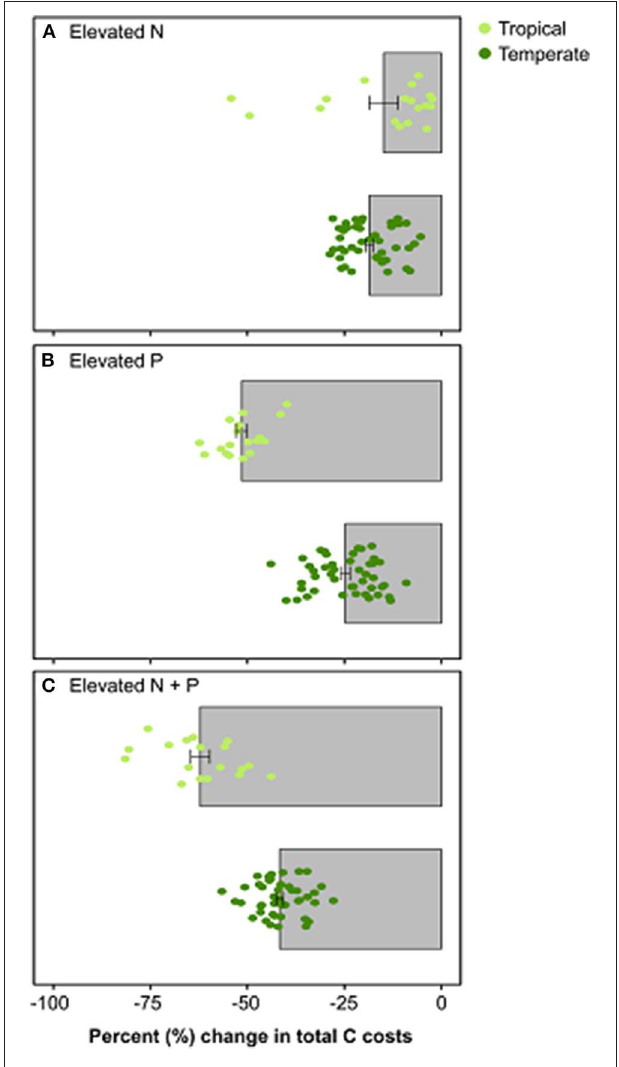
FIGURE 5 | Percent change in total C costs when (A) nitrogen is elevated by 10g m − 2 , (B) phosphorus is elevated by 10g m − 2 , and (C) both nitrogen and phosphorus are elevated by 10g m − 2 . Bars represent the mean percent change in total C costs from ambient conditions ± SE across each forest type [top bar in panel: tropical sites ( n = 18); bottom bar in panel: temperate sites ( n = 45)]. Circles represent value for each site and are color-coordinated by biome (light green: tropical sites; dark green: temperate